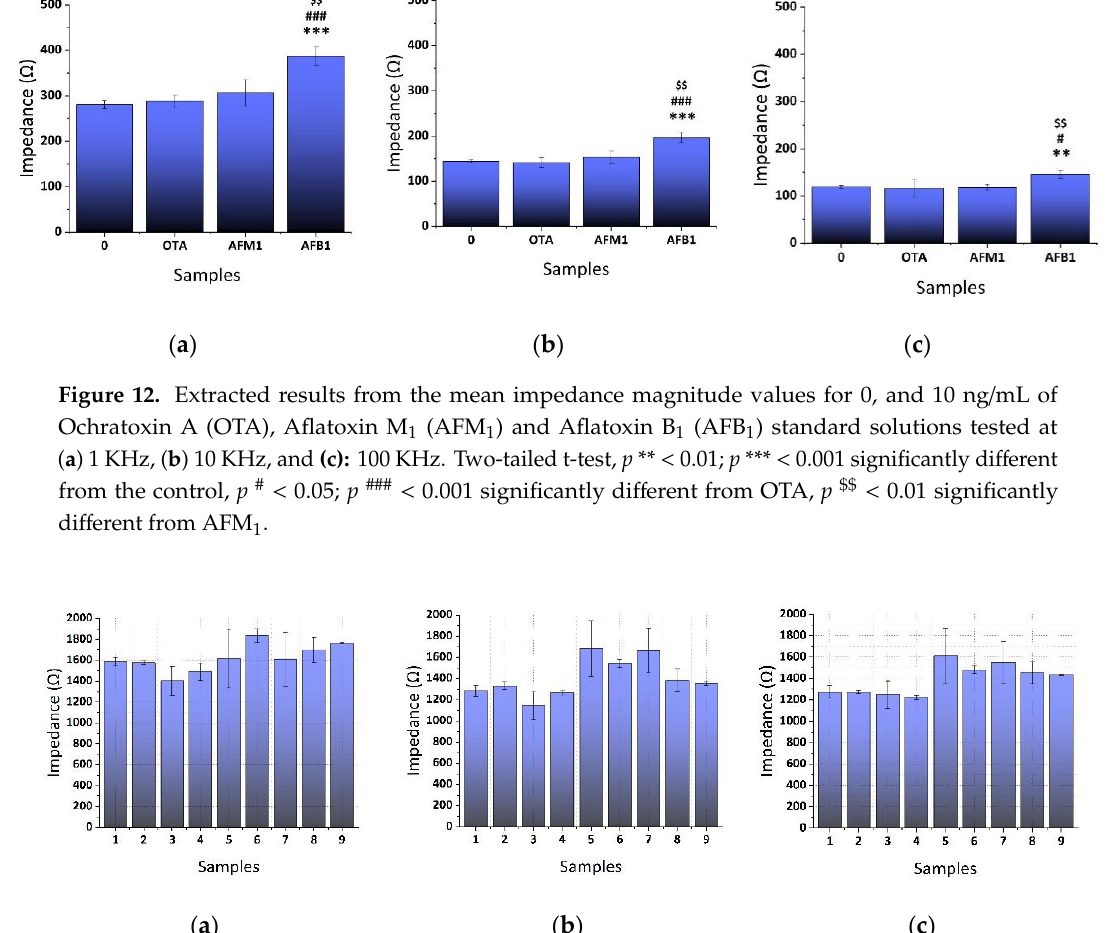
Figure 12. Extracted results from the mean impedance magnitude values for 0, and 10 ng/mL of Ochratoxin A (OTA), Aflatoxin M 1 (AFM 1 ) and Aflatoxin B 1 (AFB 1 ) standard solutions tested at ( a ) 1 KHz, ( b ) 10 KHz, and (c): 100 KHz. Two-tailed t-test, p ** < 0,01; p *** < 0,001 significantly different from the control, p # < 0,05; p ### < 0,001 significantly different from OTA, p $$ < 0,01 significantly different from AFM 1 .